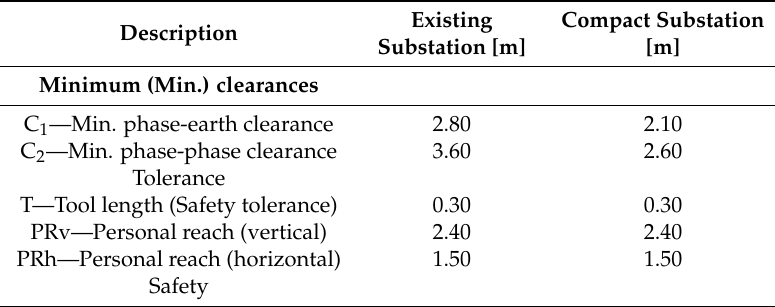
Figure 2. Busbar dimensions. Table 2. Busbar dimensions for the current UK system and the compact IEC systems (refer to Figure 2 for definitions).